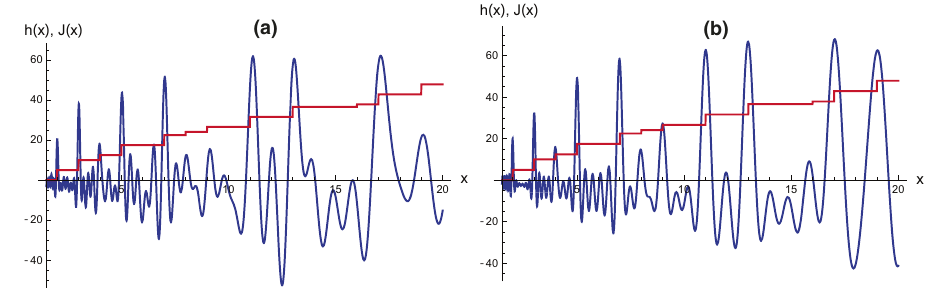
Fig. 3 Primes from zeros. The function in Eq. (2) with the sum restricted to ∣ E n ∣ < 100 (blue) and the function 5 J ( x ) given in Eq. (3) (red) are calculated ( a ) using the exact values of E n and ( b ) using the values of E n given in Table II (Extended Data) for Ω = 16. In both cases one can identify the fi rst eight primes and their powers.